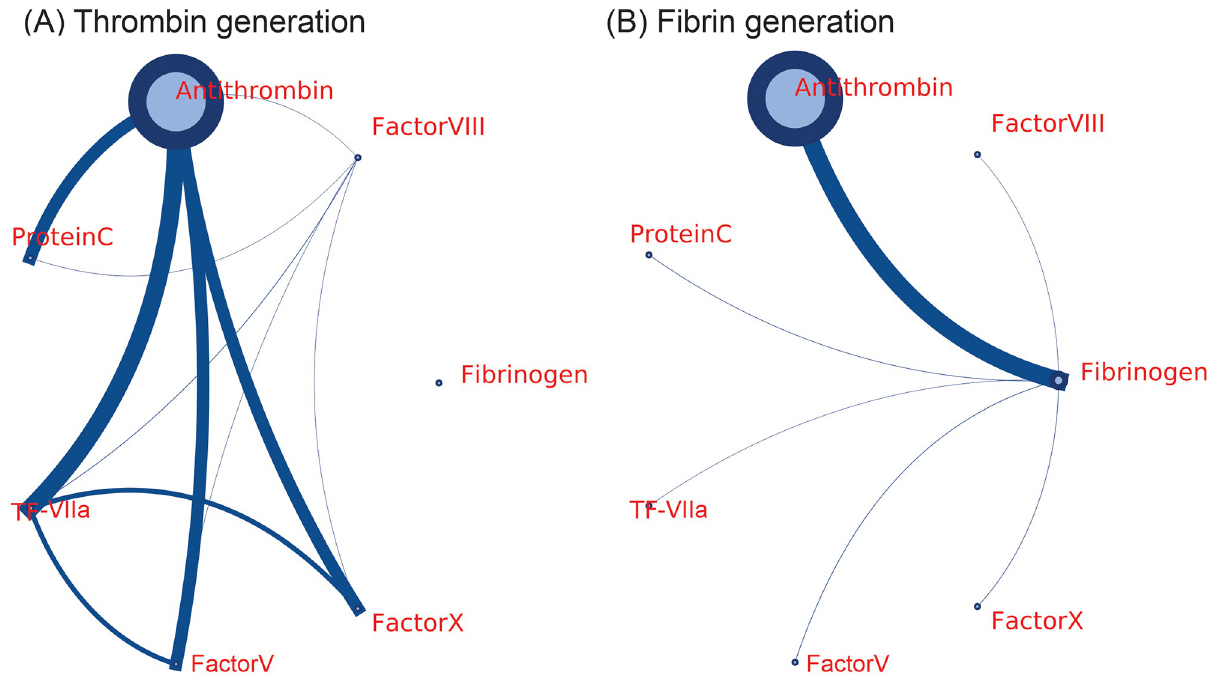
Fig 2. Global sensitivity analysis of how aberrant levels of coagulation factors in COVID-19 affect the generation of FIIa (A) and FIa (B). Circles in the figure signify the sensitivity of (A) thrombin and (B) fibrin to a single varying factor and the diameters of the circles correspond to values of the sensitivity for the examined factors. The lines that connect two factors designate the sensitivity of (A) thrombin and (B) fibrin to the two connected factors when they are varied synchronously. The thickness of the lines reflect the values of the sensitivity.